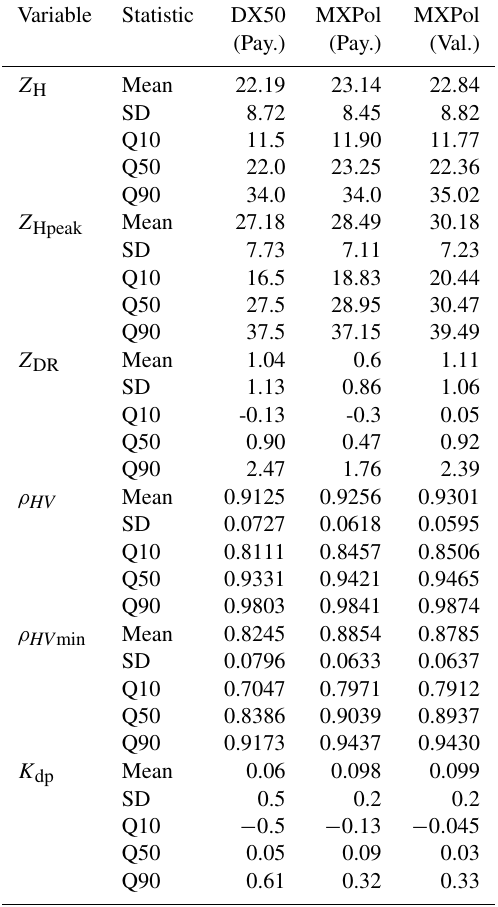
Table 2. Statistics of the polarimetric variables related to the melt- ing layer for the DX50 and MXPol in the Payerne (Pay.) and Valais (Val.) campaigns.